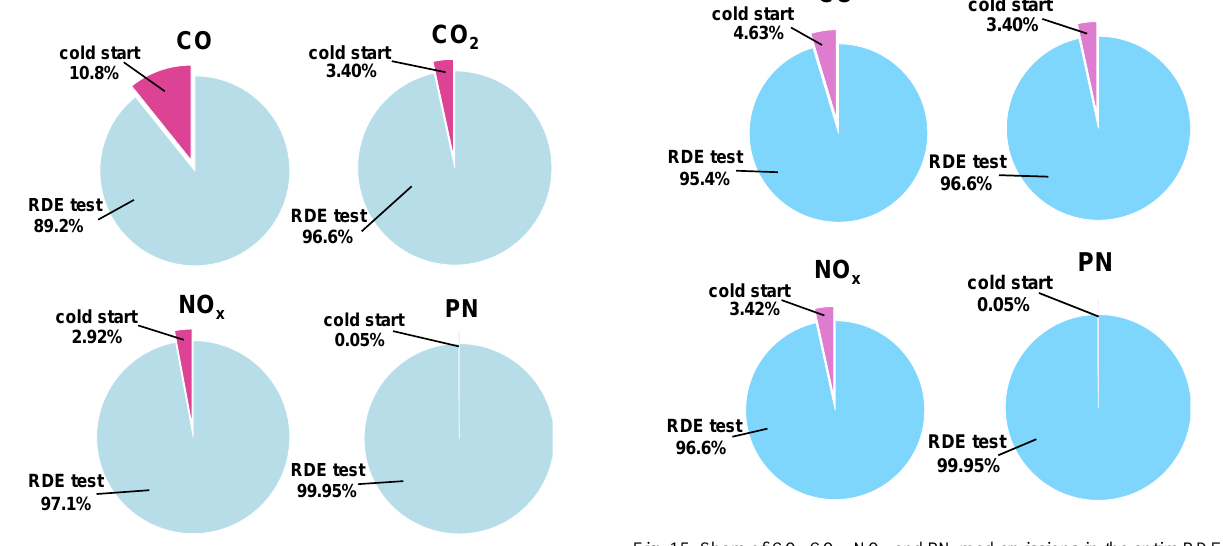
Fig. 13. Share of CO, CO 2 , NO x and PN road emissions in the entire RDE test during cold start at 8ºC